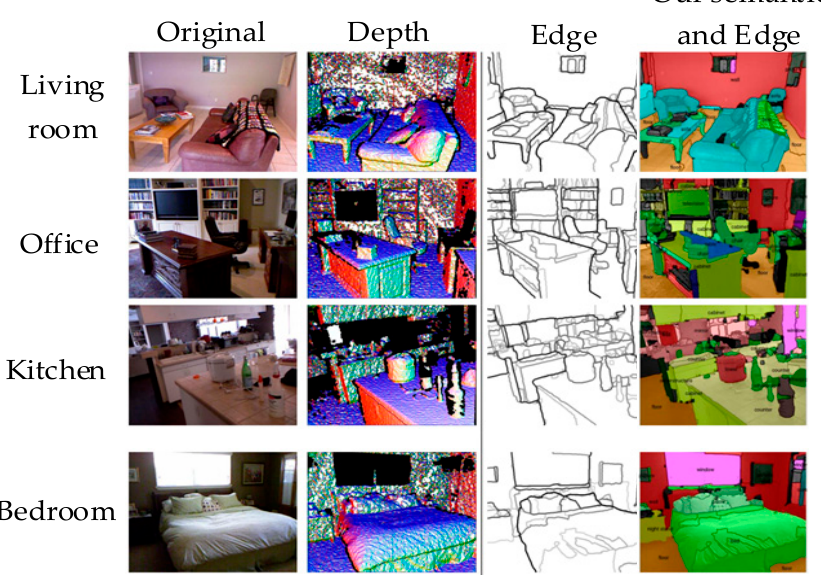
Figure 10. Segmentation results on the NYU-V2 dataset figure. The results in Figure 10 show that our semantic and edge feature fusion network is more effective, and that small objects are clear. In the second line, the “Office” scene, the objects are many and small, which poses a significant challenge to image semantic segmentation. However, the improved model is used to segment the small objects, and it can be seen that the practical effect is better. In the first and fourth rows of the scene, we can see that the edges of large objects are continuous, and the edges of the “sofa” and “bed” in the figure are more continuous.